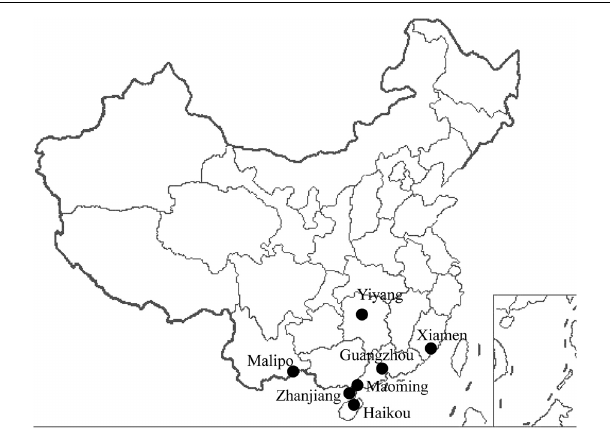
FIGURE 1 | Locations of the animal trapping sites in China. Map source: https://image.so.com/view?q=%E4%B8%AD%E5%9B%BD%E5%9C%B0% E5%9B%BE&src=srp&correct=%E4%B8%AD%E5%9B%BD%E5%9C%B0% E5%9B%BE&ancestor=list&cmsid=50712c46325496ee4c7fbfbded18f06e& cmras=0&cn=0&gn=0&kn=50&crn=0&bxn=20&fsn=130&cuben=0&pornn=0& manun=50&adstar=0&clw=233#id= 812433445ba11b77cba553308beab1d9&currsn=0&ps=136&pc=136